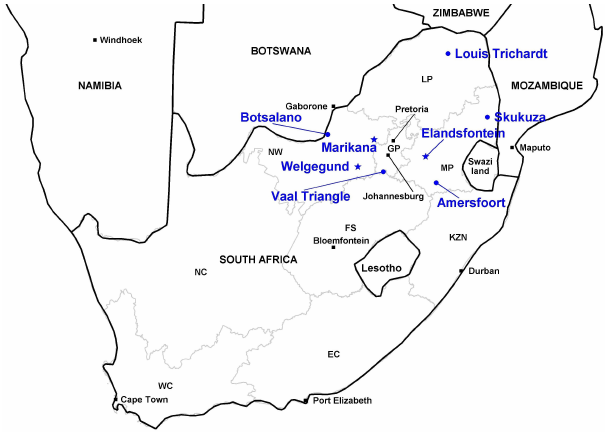
Figure 1. The sites (Elandsfontein, Welgegund and Marikana) where continuous high-resolution data were gathered are indicated with blue stars, while the sites (Louis Trichardt, Skukuza, Vaal Tri- angle, Amersfoort and Botsalano) where filters were gathered and analysed offline are indicated with blue dots. Neighbouring coun- tries, some major cities and South African provincial borders are also indicated for additional regional contextualisation (Provinces include WC – Western Cape; EC – Eastern Cape; NC – Northern Cape; FS – Free State; KZN – KwaZulu-Natal; NW – North